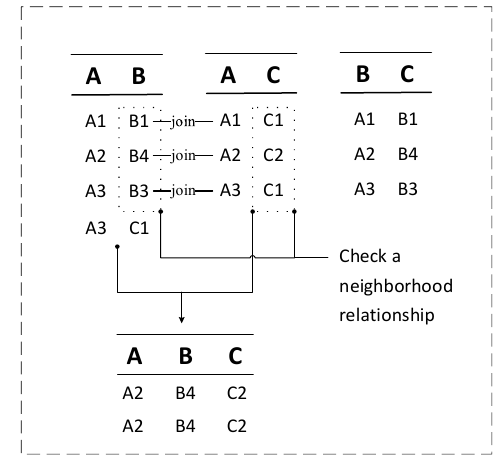
Figure 2. The steps of join in join-based algorithm The join steps (Yoo, Shekhar, 2006) in the join-based algorithm (as shown in Figure 2) are as follows: select the co-location mode C kp and C kq from the k-order candidate co-location table C k , and connect them to generate the k-order co-location mode and insert them into the k-order candidate co-location table C k+1 .